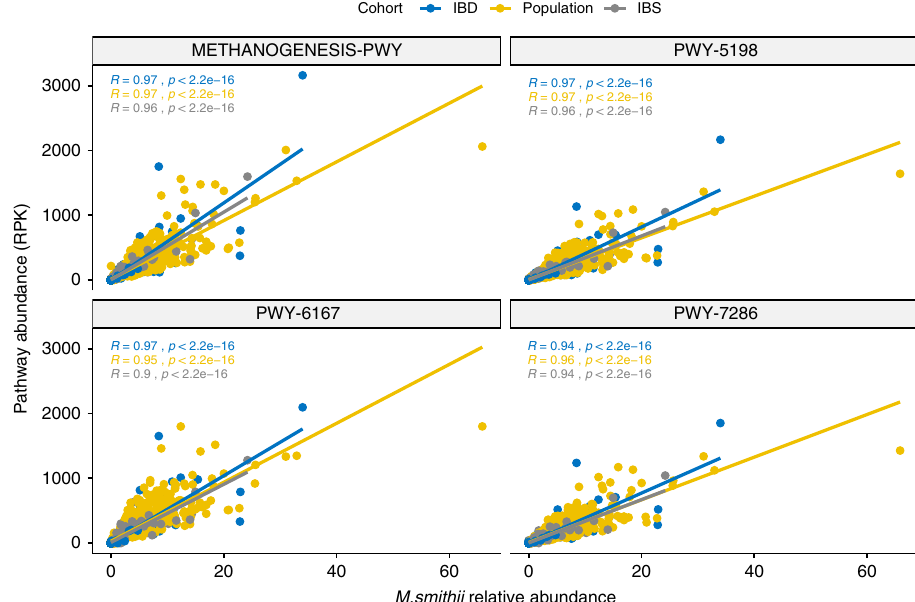
Fig. 3 Correlation between the relative abundance of Methanobrevibacter smithii and the pathways associated with oral steroids. Dots are coloured by study cohort. In blue the cohort of IBD patients, in yellow the population cohort and in grey the IBS case-control cohort. X -axis represents the relative abundance of Methanobrevibacter smithii and Y -axis the read per kilobase (RPK) of each pathway. Spearman correlation was used to calculate the correlation and signi fi cance. (Source data are provided as a Source Data fi